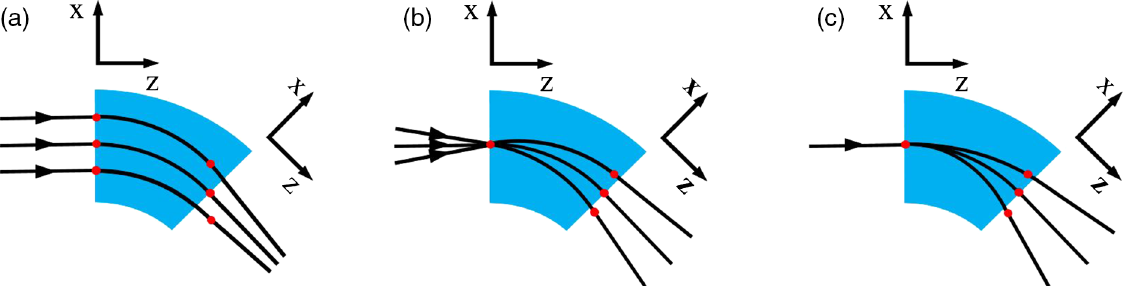
FIG. 6. Linear transverse-longitudinal coupling induced by a bending magnet. Particles with different horizontal positions (a) and angles (b) pass the horizontal bending magnet along different paths, resulting in longitudinal coordinate differences. Particles with different energies (c) also pass the horizontal bending magnet along different paths, resulting in horizontal position and angle